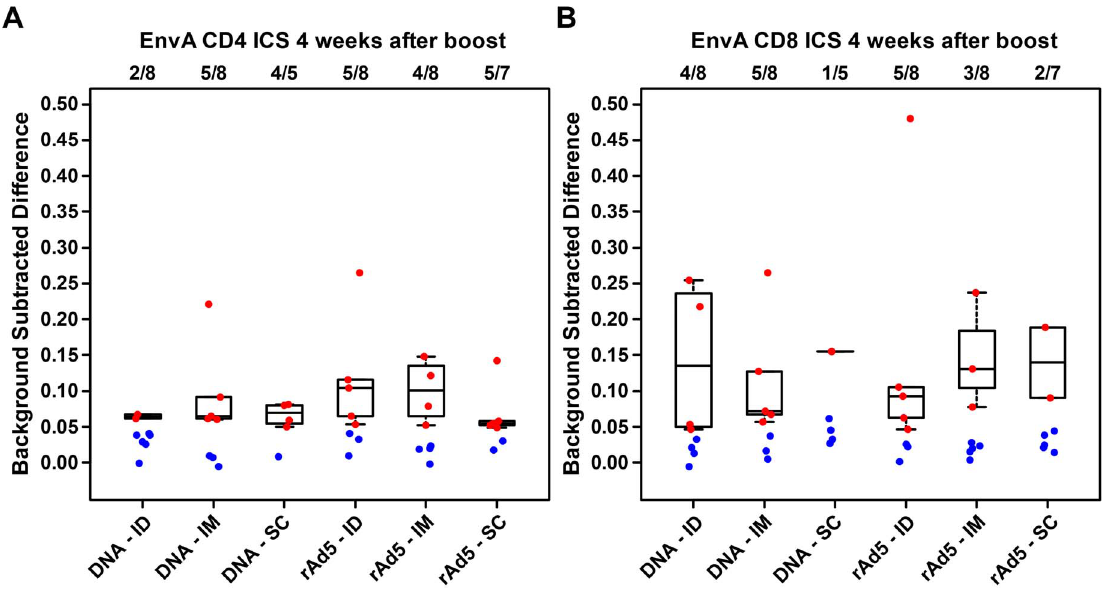
Figure 3. ICS responses among the different priming groups after boosting with rAd5 IM for CD4 T cells (A) and CD8 T cells (B). The numbers above each boxplot represent the fraction of participants in each group with available data at that time point who were judged to be responders using predefined positivitycriteria. The responders are represented on the plot with red dots, and are used to construct the boxplots; blue points represent non-responders and are not included in the boxplots.